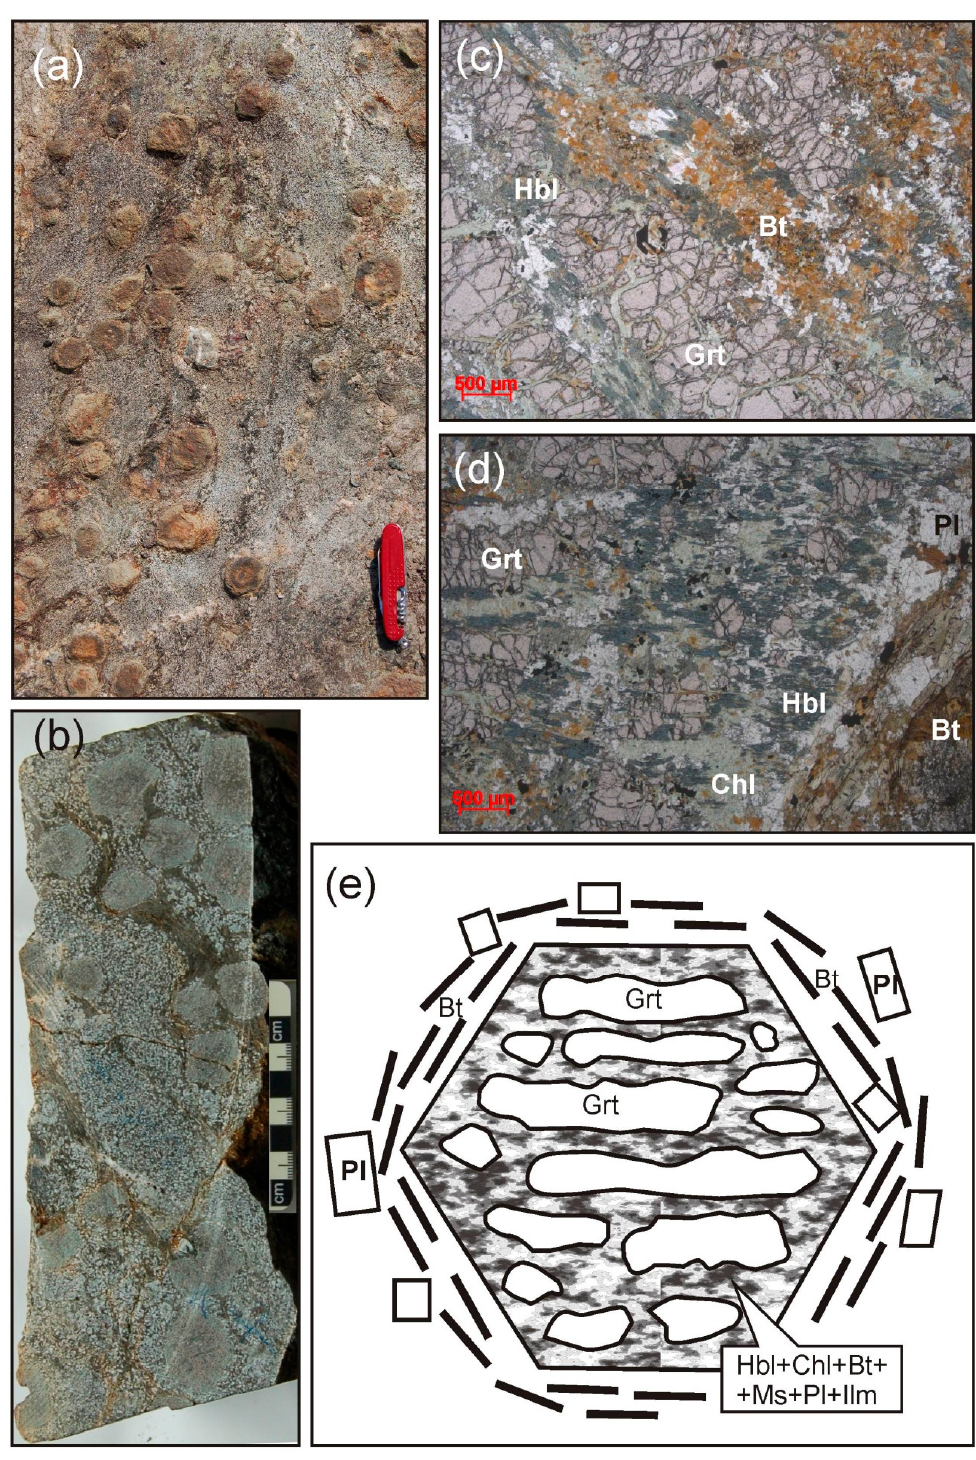
Figure 5. Garnet porphyroblasts in diorite-gneiss: view in the outcrop ( a ), view in a polished slice of rock ( b ), photo of a thin section in plane polarized light ( c,d ), and internal structure ( e ). Bt—biotite, Pl—plagioclase, Grt—garnet, Hbl—hornblende, Chl—chlorite, Ms—muscovite, Ilm—ilmenite.